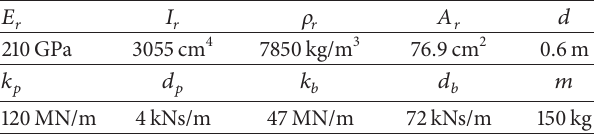
Table 3: Parameters of the track at M´evergnies (Belgium).